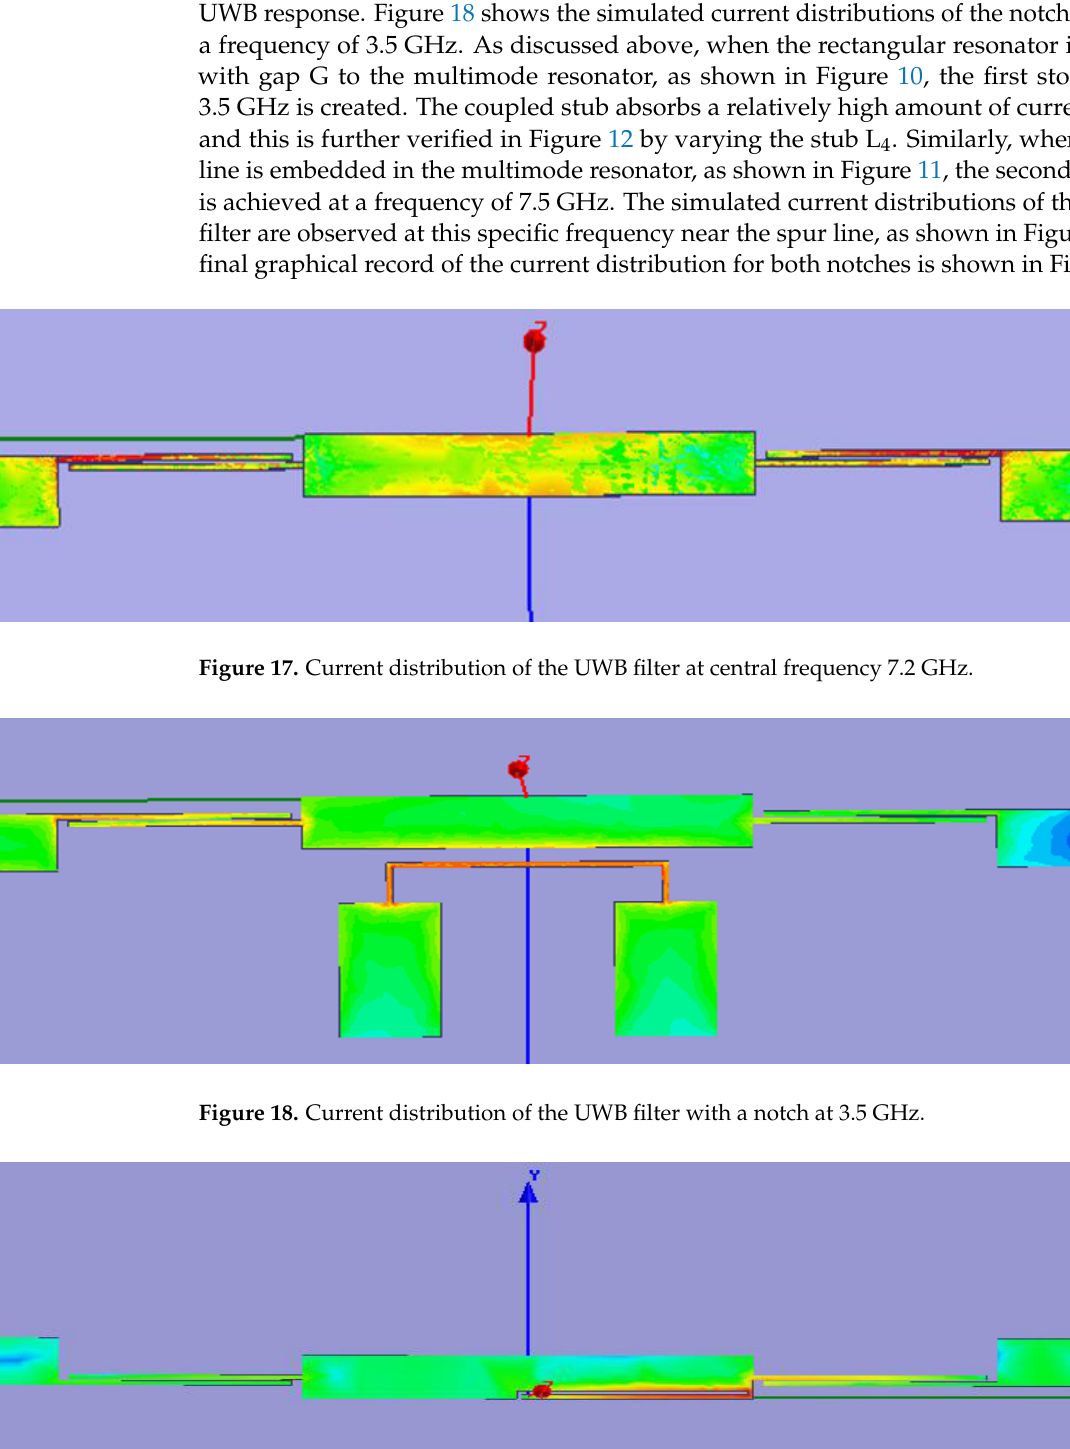
Figure 19. Current distribution of the UWB filter with a notch at 7.5 GHz.